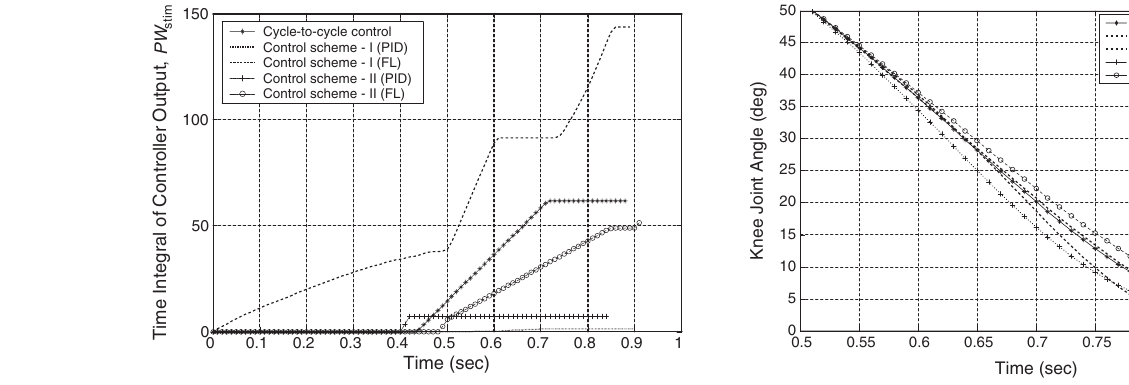
Fig. 20. Knee extension generated with FES muscle force output 80% of its normal value (simulated fatigue). draw conclusive comparison of their fatigue resistance